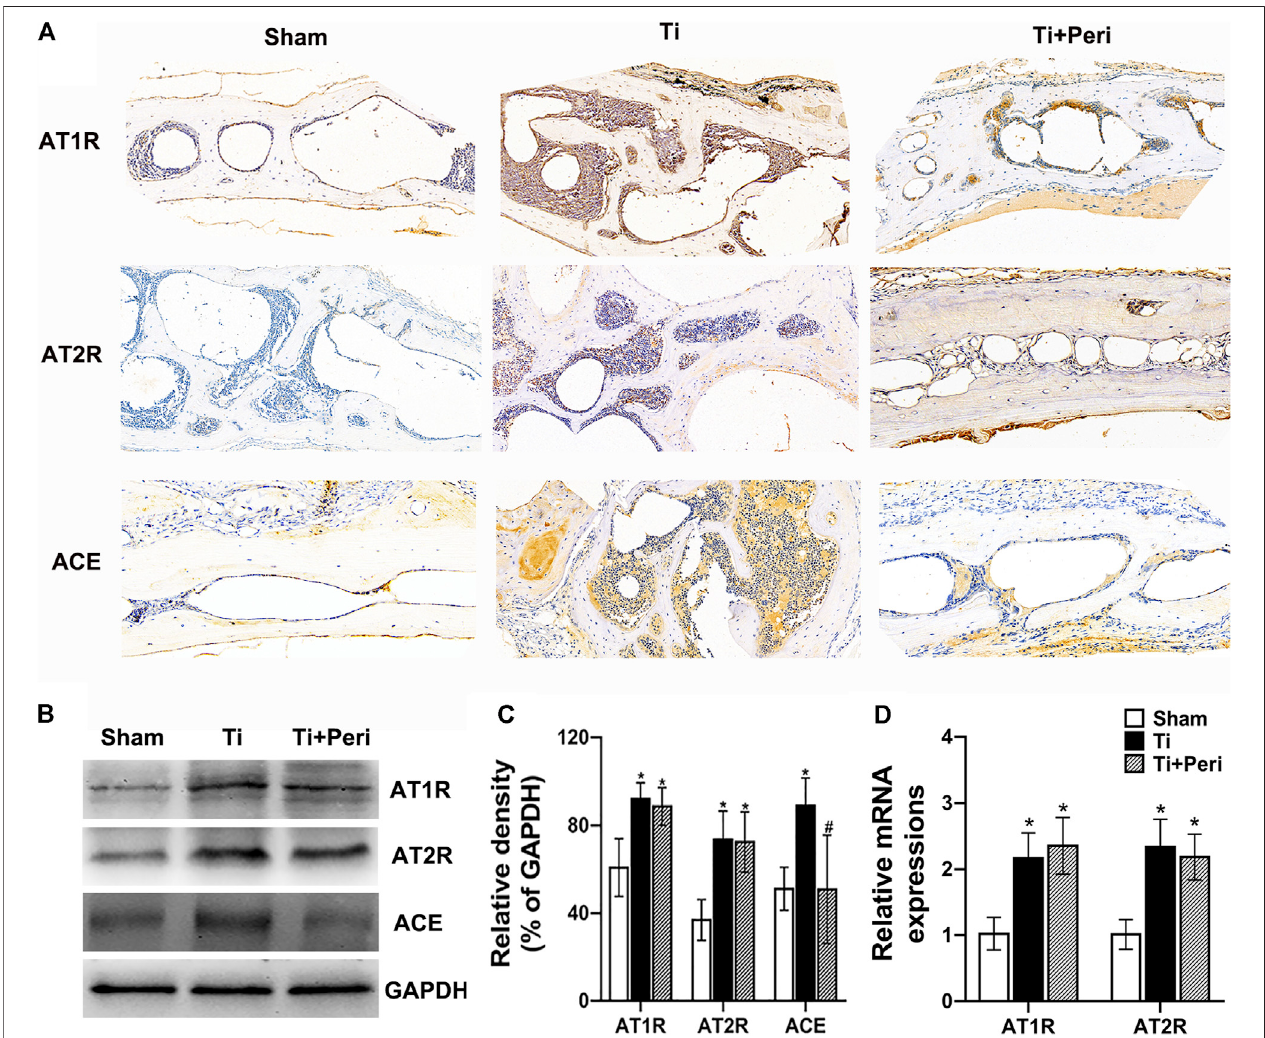
FIGURE 2 | Up-regulated AT1R, AT2R, and ACE expressions in the mice calvarial tissue of Ti-particle-induced osteolysis. The levels of AT1R, AT2R, and ACE in mice calvarial tissue samples were determined by immunohistochemistry, Western blot or RT-qPCR. Data are representative images or expressed as the mean ± SD of eachgroupfromthreeseparateexperiments( n (cid:1) 3pergroup). (A) Representativeimmunohistochemistryimages(magni fi cation × 400). (B,C) Westernblotanalyses. (D) RT-qPCR analyses. * p < 0.05 vs. the sham group; # p < 0.05 vs. the Ti group.